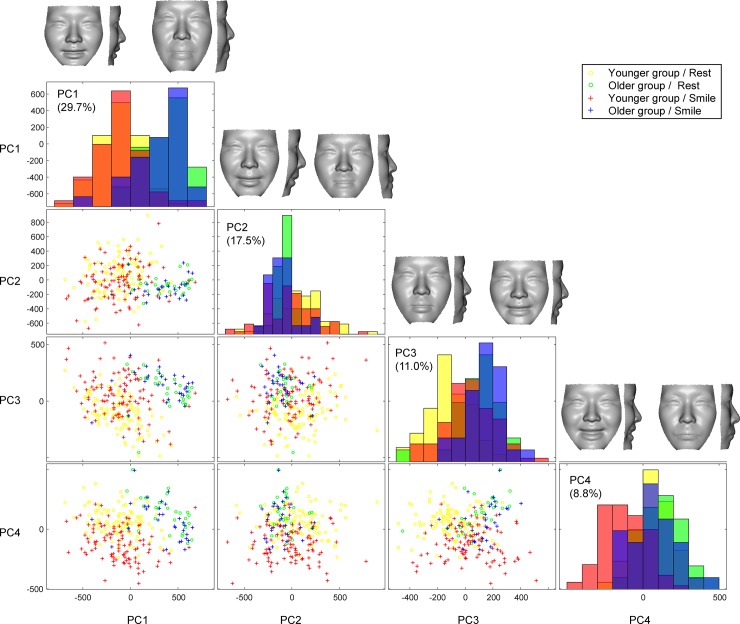
A scatter plot matrix of the principal component (PC) scores for rest
and smiling postures in the younger and older groups with a histogram in
diagonal cells.PCs 1–4 explains 67.0% of shape variation across samples. The PC1 shows a
clear separation between age groups. Yellow denotes facial
configurations at rest in younger group; green, those at rest in older
group; red, those at the peak of smiling in younger group; blue, those
at the peak of smiling in older group. Shape changes associated with PCs
1–4 are shown in the top column.